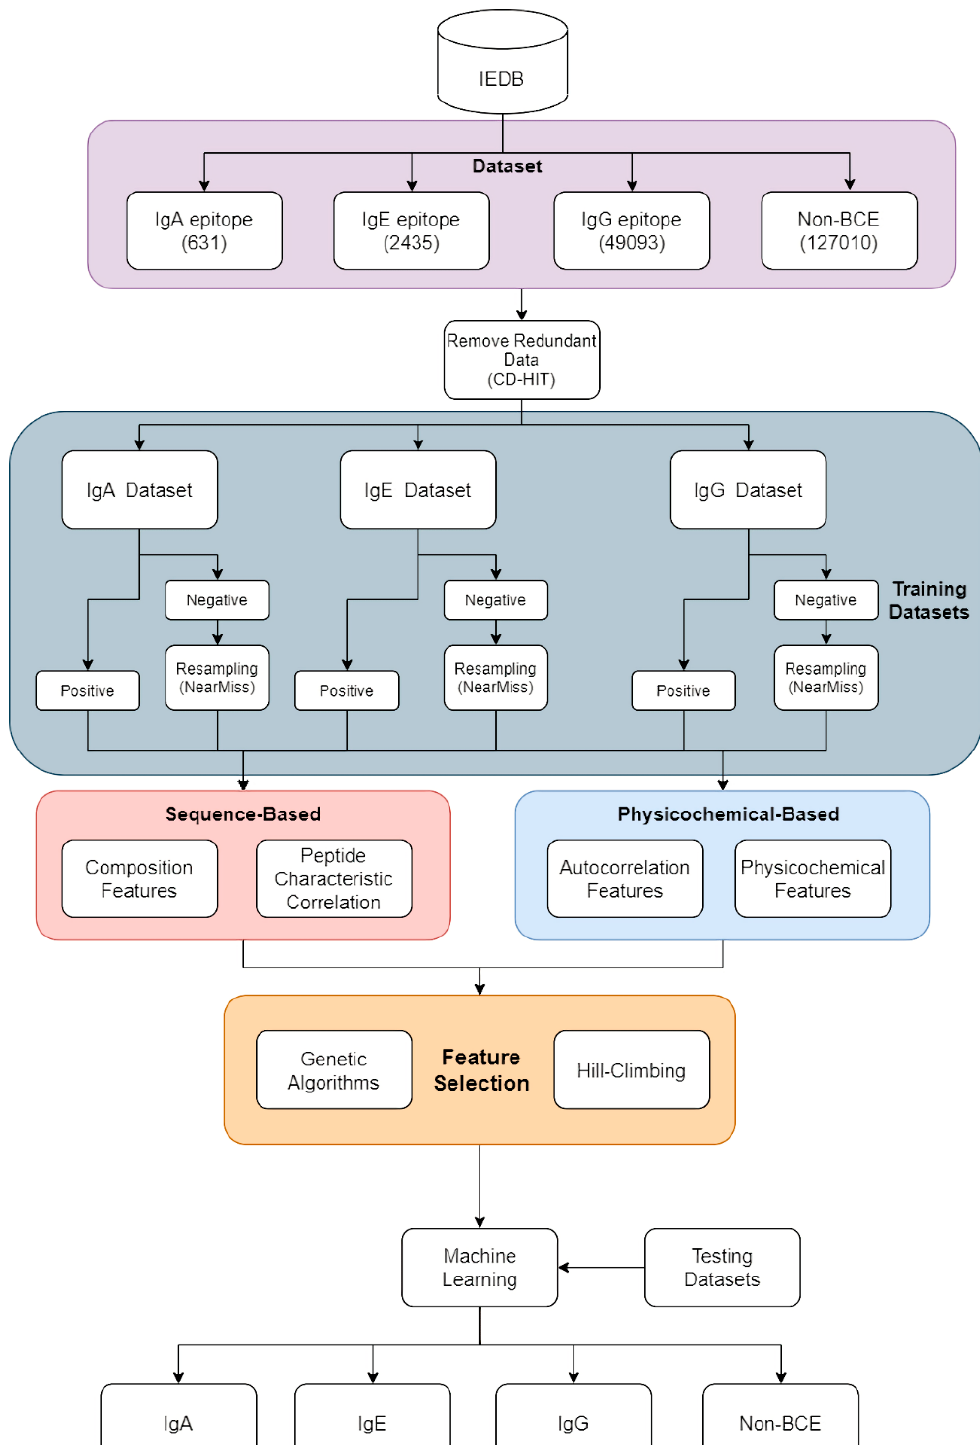
Figure 1. The experimental architecture of NIgPred.